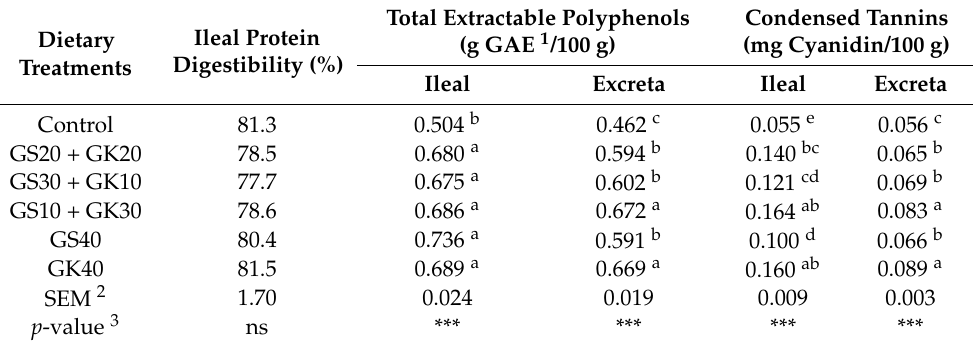
Table 3. Effect of grape seed (GS) and grape skin (GK) meals added at different dietary concentrations (g/kg) on ileal protein digestibility and on ileal and excreta total extractable polyphenols and condensed tannins contents in broiler